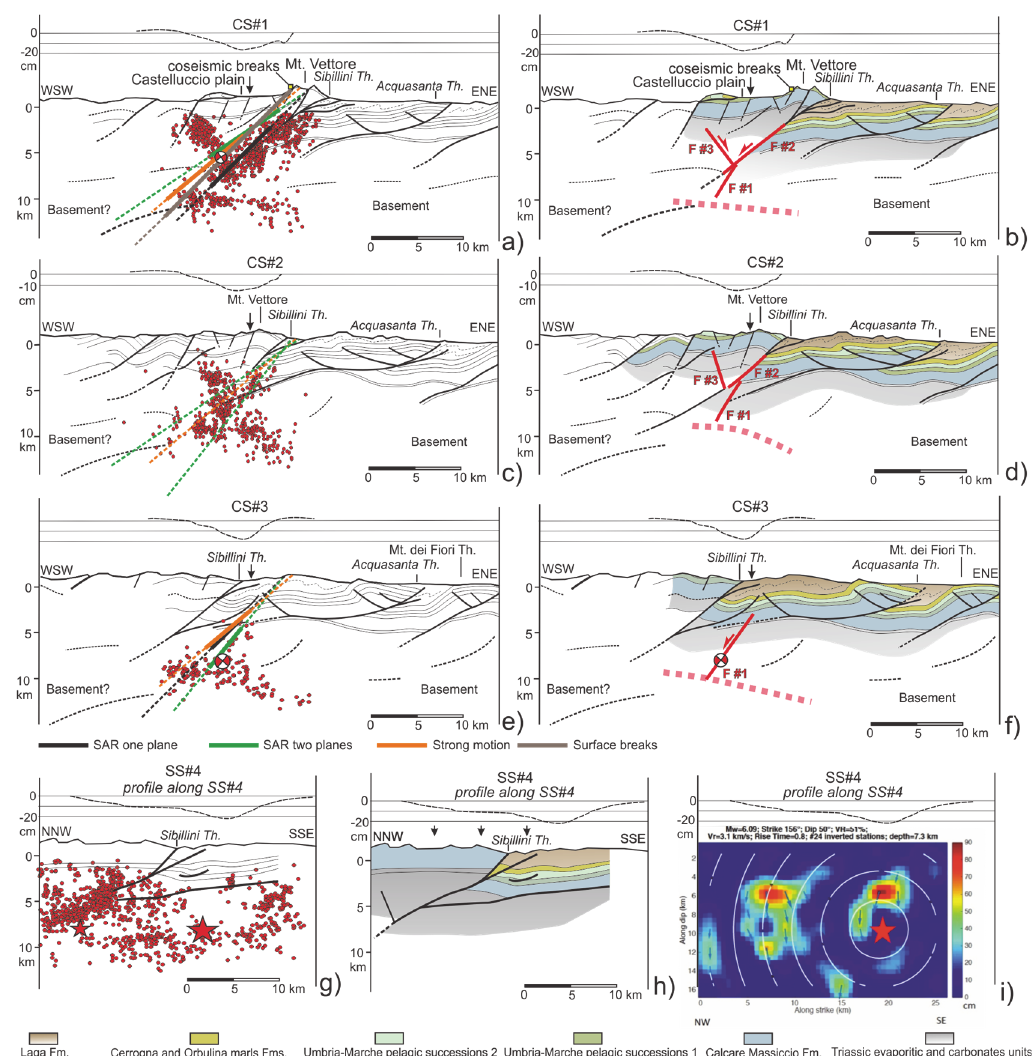
Figure 2. (a, c, e, g) Transversal (CSx) and longitudinal (SSx) geological sections across the aftershock pattern of the Amatrice sequence: each panel shows aftershocks falling within a 2.5 km range from the section plane (updated as of 15 September 2016; data from Michele et al., 2016). The sections also show the trend of model faults derived from InSAR and seismological data. (b, d, f, h) Geological sections showing the main faults that participated in the earthquake sequence (see Discussion section). A profile of InSAR-detected elevation changes (from ALOS-2) is plotted above each section. See Figure 1 for the traces of the sections. i) Model obtained from the inversion of strong motion data, showing the mainshock slip distribution (Tinti et al.,